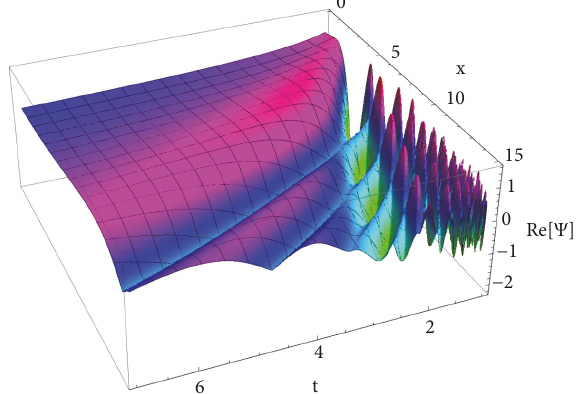
Figure 2: The projection of the real part of the wave function (12) along the x-t